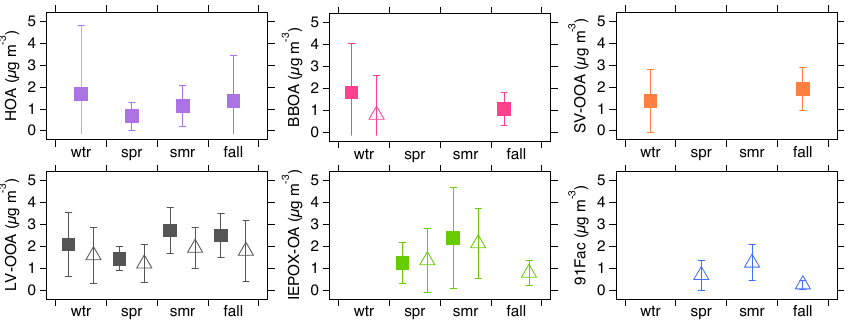
Figure 8. Seasonal average mass concentrations of PMF factors resolved from JST (solid squares) and LRK (open triangles). Error bars are shown as ± 1 standard